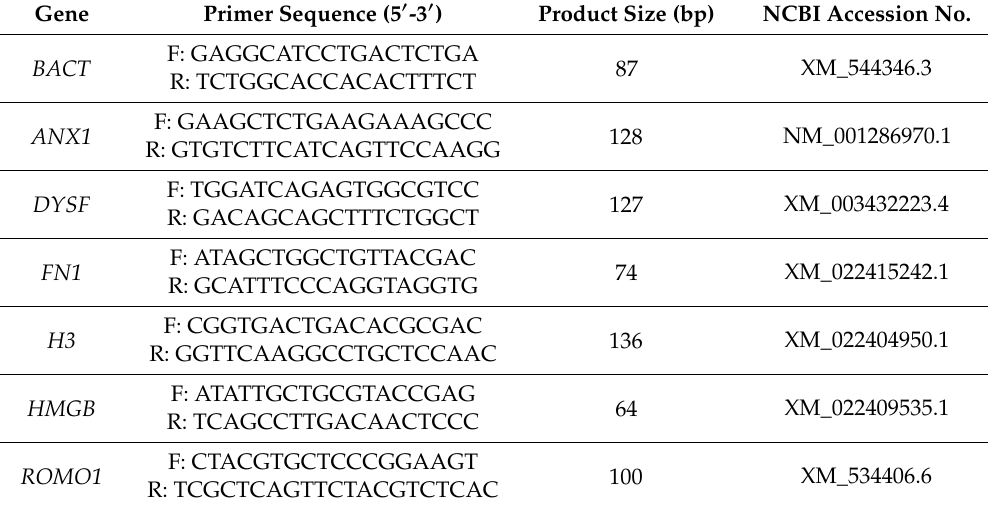
Table 1. Primer sequences used for gene expression